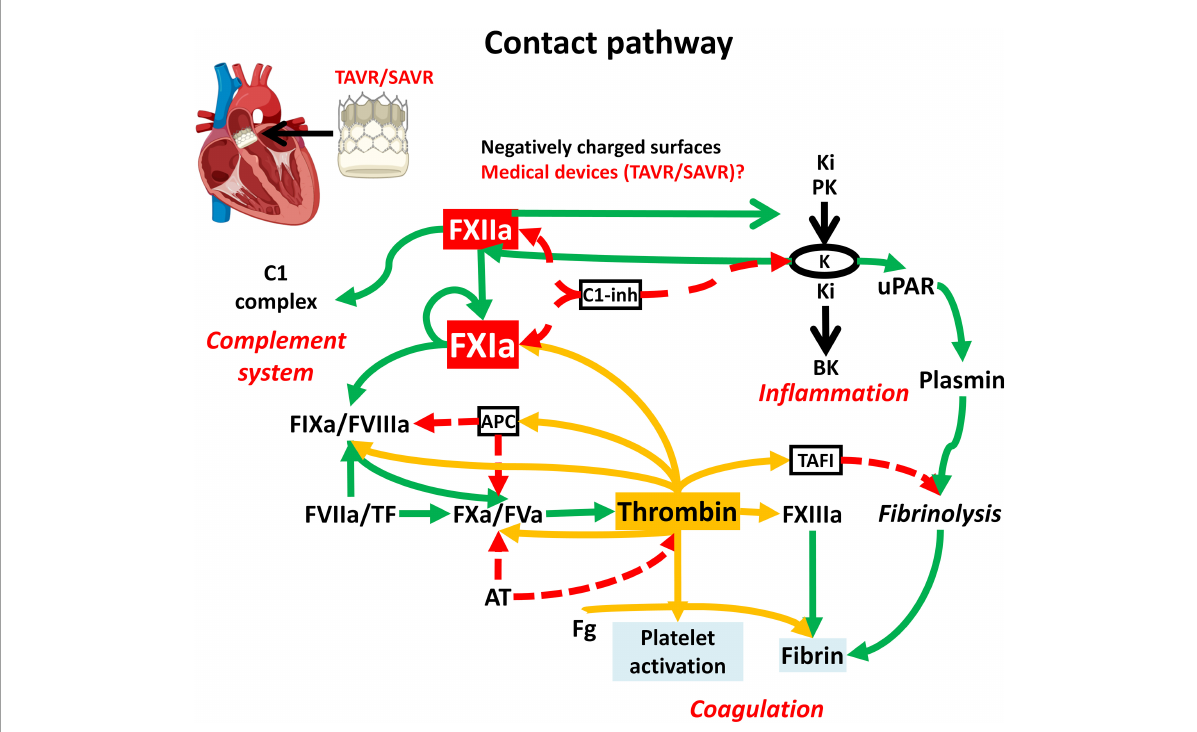
FIGURE1 Scheme of the contact pathway and its involvement in coagulation, inflammation and complement system. Surgical (SAVR) or transcatheter (TAVR) aortic valve is illustrated as a potential trigger of FXII autoactivation. Dashed red arrows indicate inhibition; green arrows activation; yellow arrows activation by thrombin. APC, activated protein C; Ki, Kininogen; PK, prekallikrein; K, kallikrein; BK, bradykinin; TAFI, thrombin activable fibrinolysis inhibitor; Fg, fibrinogen; C1-inh, C1-inhibitor; uPAR, urokinase-type plasminogen; TF, Tissue